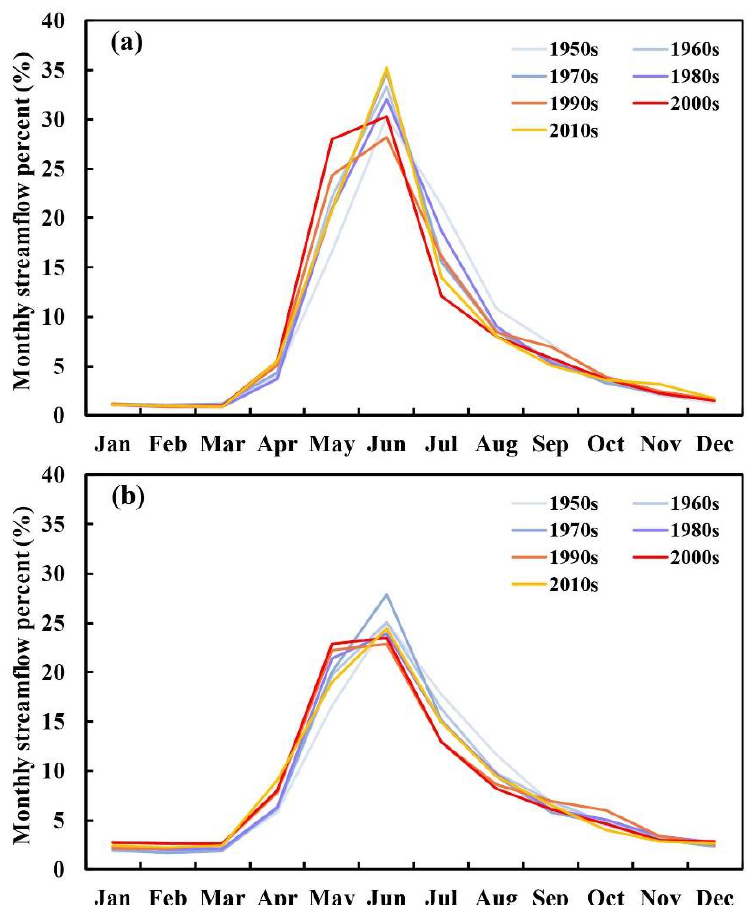
Figure 5. Observed changes in the monthly runoff distributions during the periods 1957–2015 at the ( a ) Kuwei and ( b ) Kelatashi hydrological stations in the SAM.